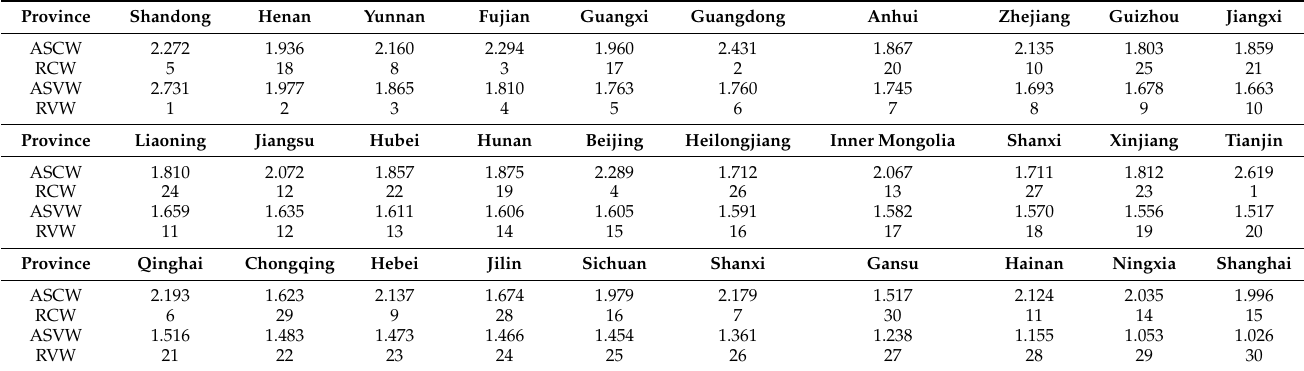
Table 8. Ranking of score of constant weight and variable weight of 30 provincial-level regions in China in